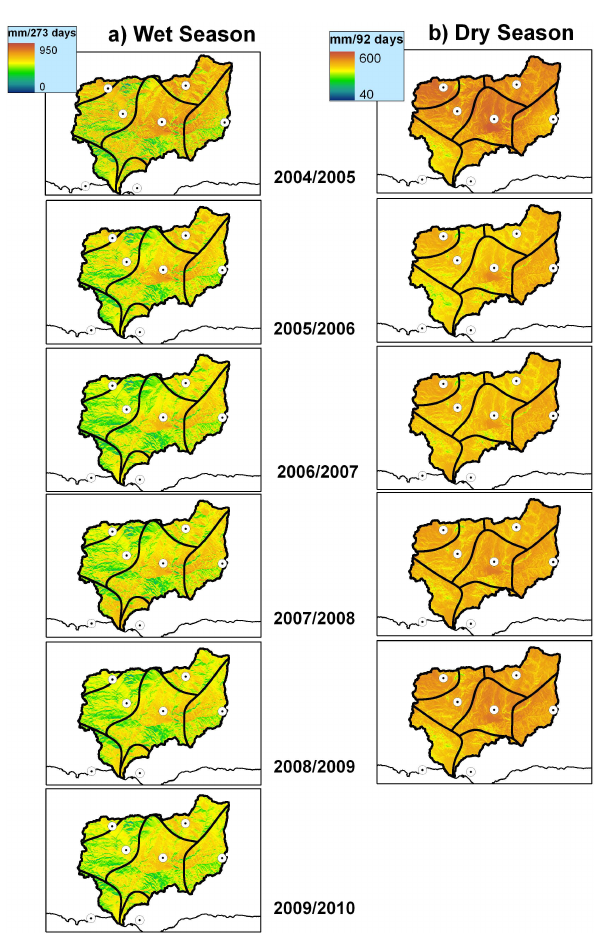
Fig. 6. Regions of influence and ASCE-PM ET 0 estimates at the Guadalfeo river watershed for the (a) wet season (1 September– 31 May) and (b) the dry season (1 June –31 August).